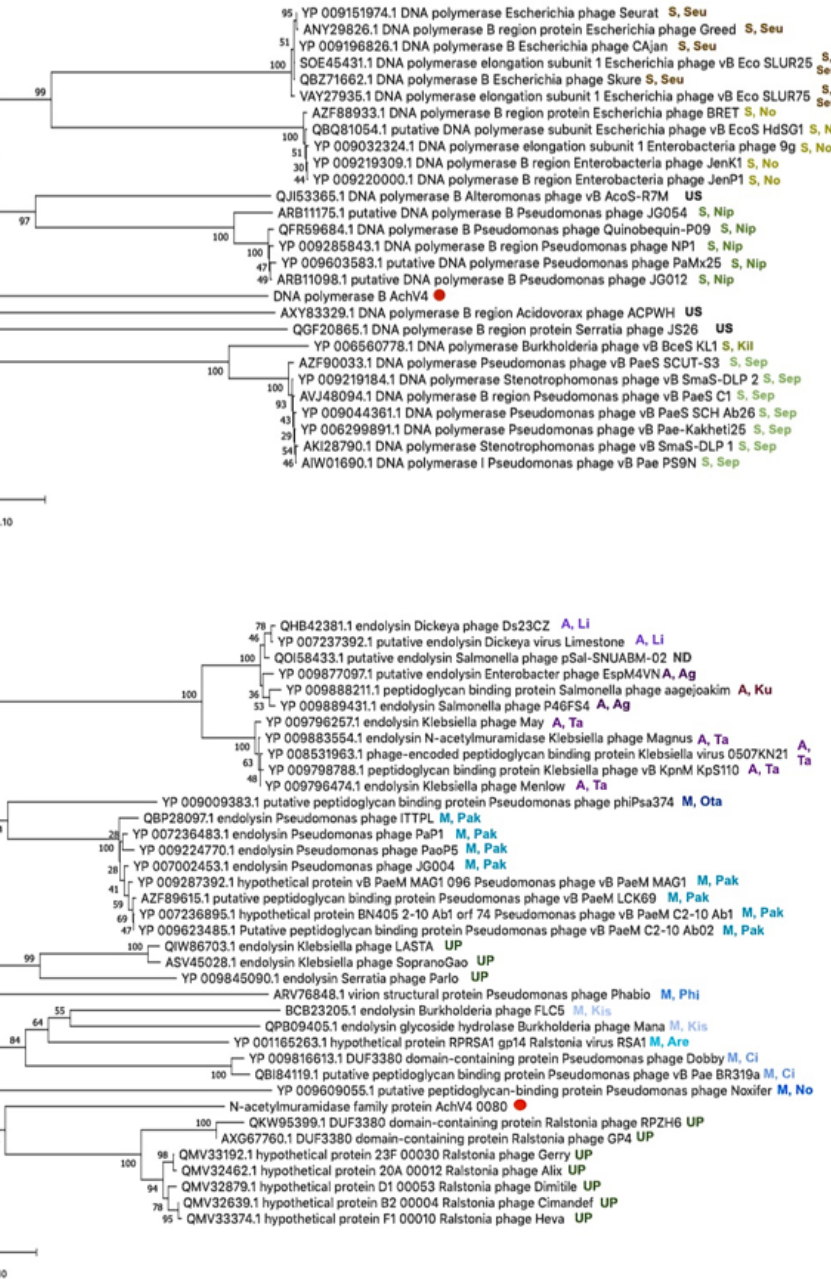
Figure 4. Phylogenetic analysis. Neighbor-joining tree analysis based on the ClustalW alignment of: DNA polymerase ( A ) and phage endolysin ( B ) sequences. The percentage of replicate trees in which the associated taxa clustered together in the bootstrap test (500 replicates) is shown next to the branches. Evolutionary analyses were conducted in MEGA X. US—unclassified siphovirus; UM—